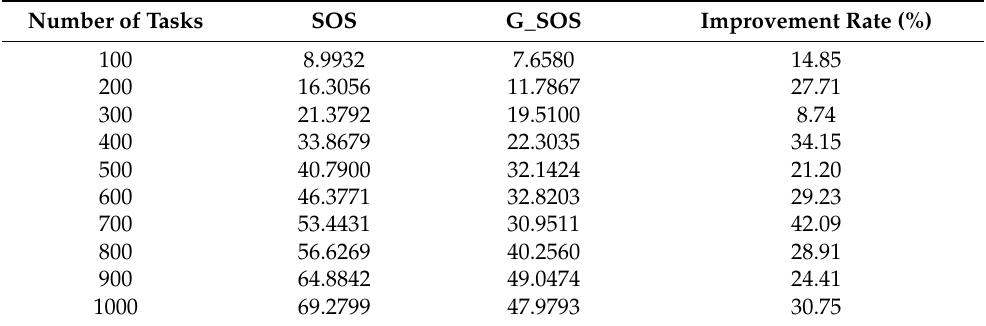
Table 8. Comparison of the Response Time of SOS and G_SOS for a uniformly distributed dataset.